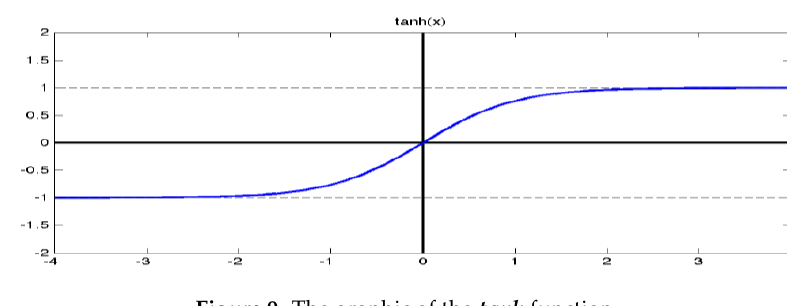
Figure 9. The graphic of the tanh function.